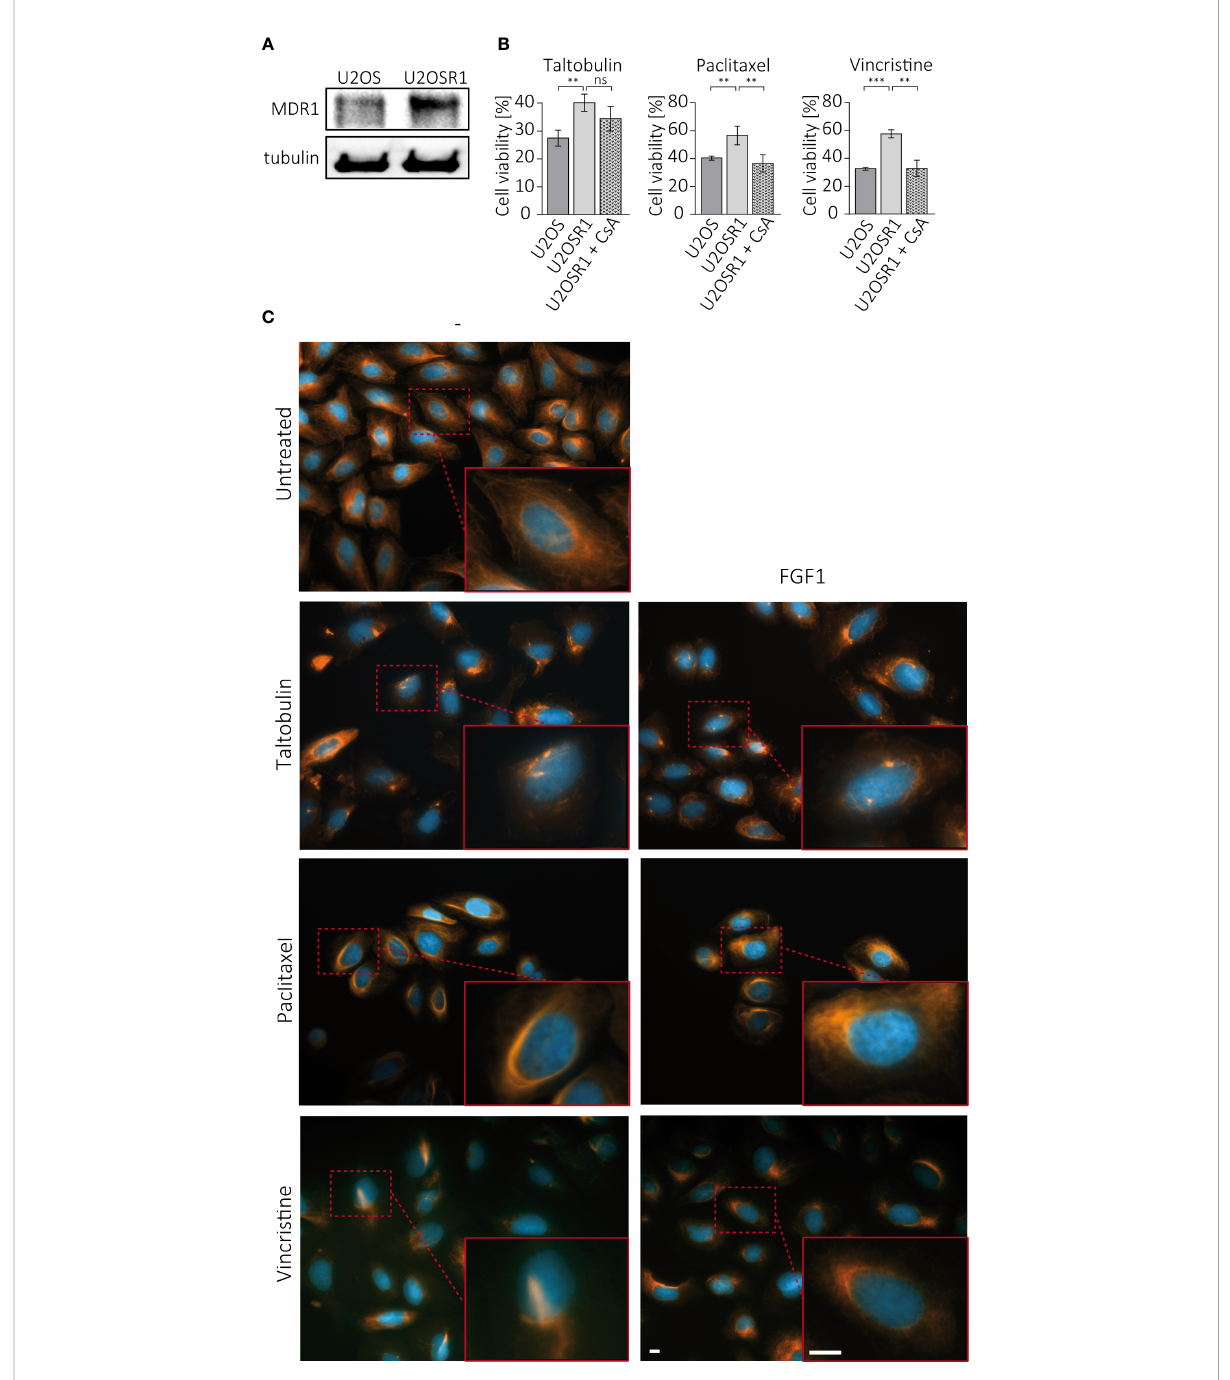
FIGURE 3 Effect of cell membrane transporters on the FGFR1-dependent protective effect against TLT, PTX and VCR. (A) MDR1 levels in U2OS and U2OS- R1 cells were analyzed by western blotting using anti-MDR1 antibody. (B) The effect of MDR1 inhibition with 10 µM cyclosporine A (CsA) on drug sensitivity in U2OSR1 cells was checked by monitoring cell viability 48 h after drug administration with the alamarBlue assay. Results represent the mean ± SD of at least three independent experiments and are normalized to untreated cells (w/o drug and CsA); statistical signi fi cance: **p<0.01, ***p<0.001, no signi fi cant differences are marked as ‘ ns ’ . (C) Changes in microtubules structures after 24-h treatment with drugs (5 nM TLT, 20 nM PTX, 10 nM VCR) and the effect of FGF1 (10 ng/mL) on this process were visualized by fl uorescence microscopy using antibodies against acetylated-tubulin. Scale bar represents 10 m